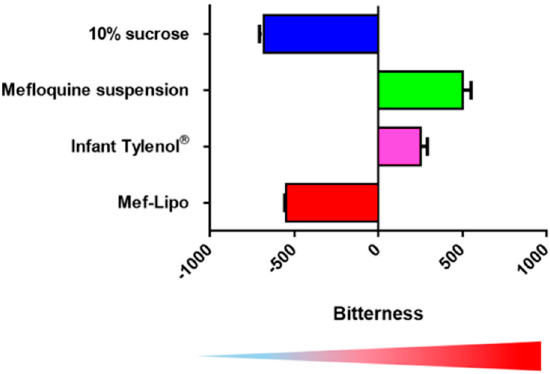
Figure 6. Quantification of bitterness of various drug formulations using the e-tongue. Data = mean ± Standard Deviation (SD) ( n = 3). The figure is adapted with permission from Tang et al., Molecular Pharmaceutics; published by American Chemical Society, 2017 [23].